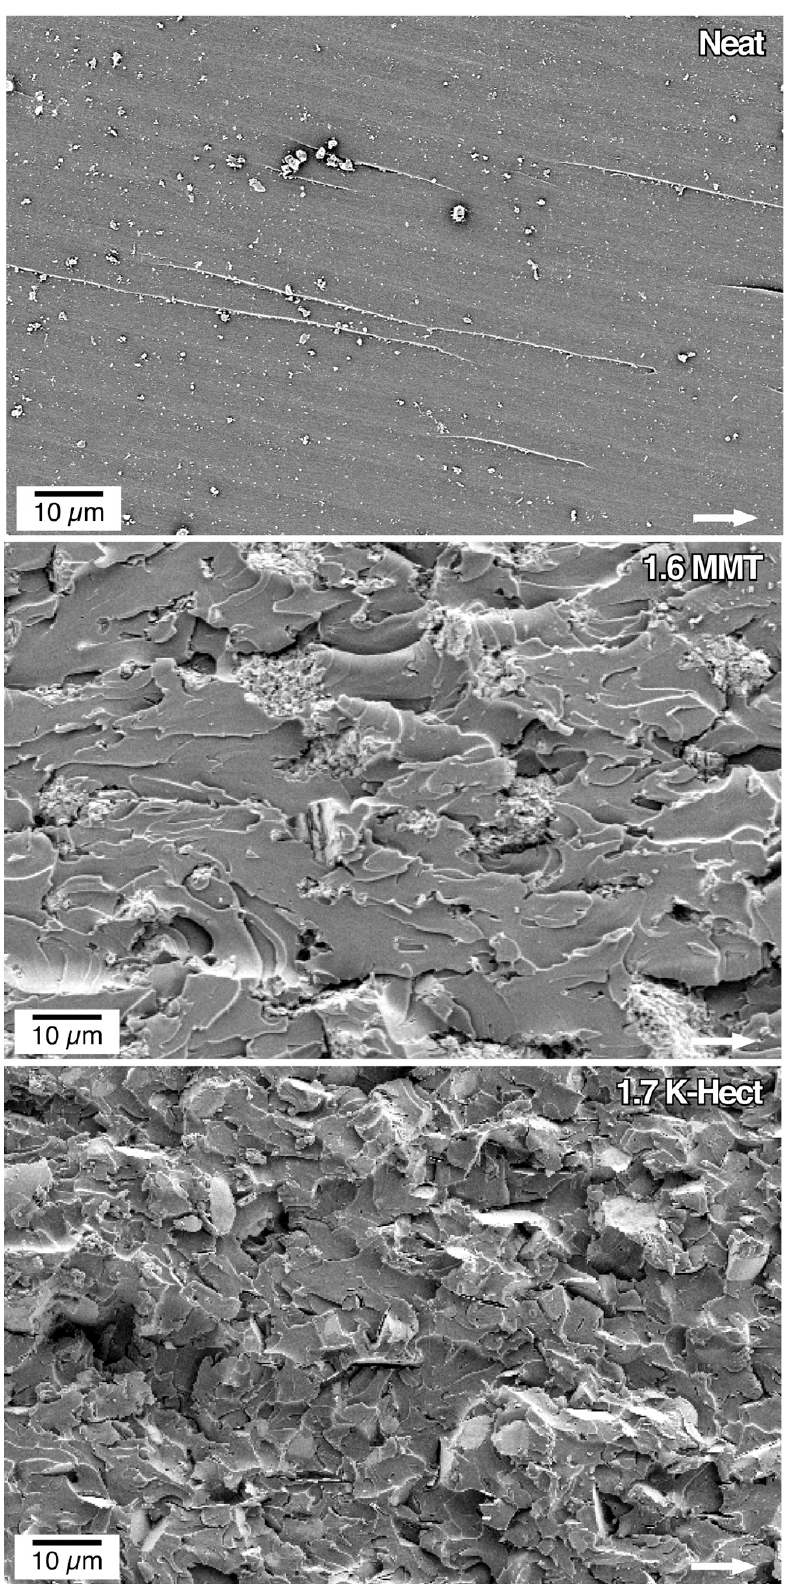
Figure 6. SEM pictures of the fracture surface of compact tension samples (filler content in vol % is given in the pictures). The white arrow shows the direction of crack propagation.